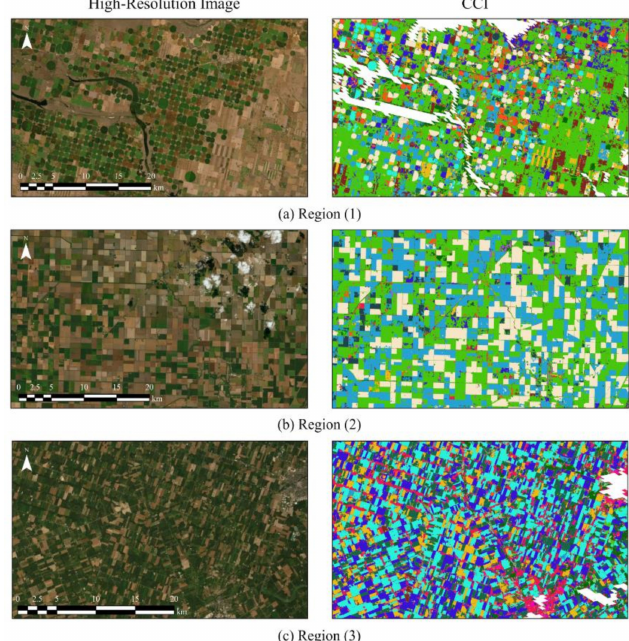
Figure 6. Three zoomed regions of the Annual Space-Based Crop Inventory (ACI) map along with the corresponding high-resolution satellite images used for visual assessment (see Figure 5 for the location of each region and the legend of the